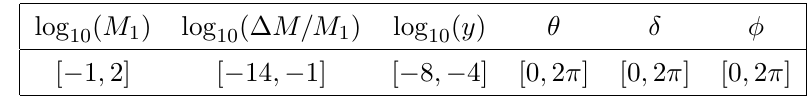
Table 3 . Priors for the nested